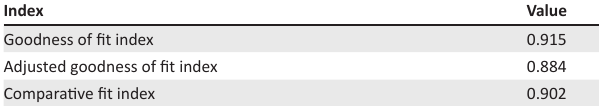
TABLE 10: Goodness of fit indices final